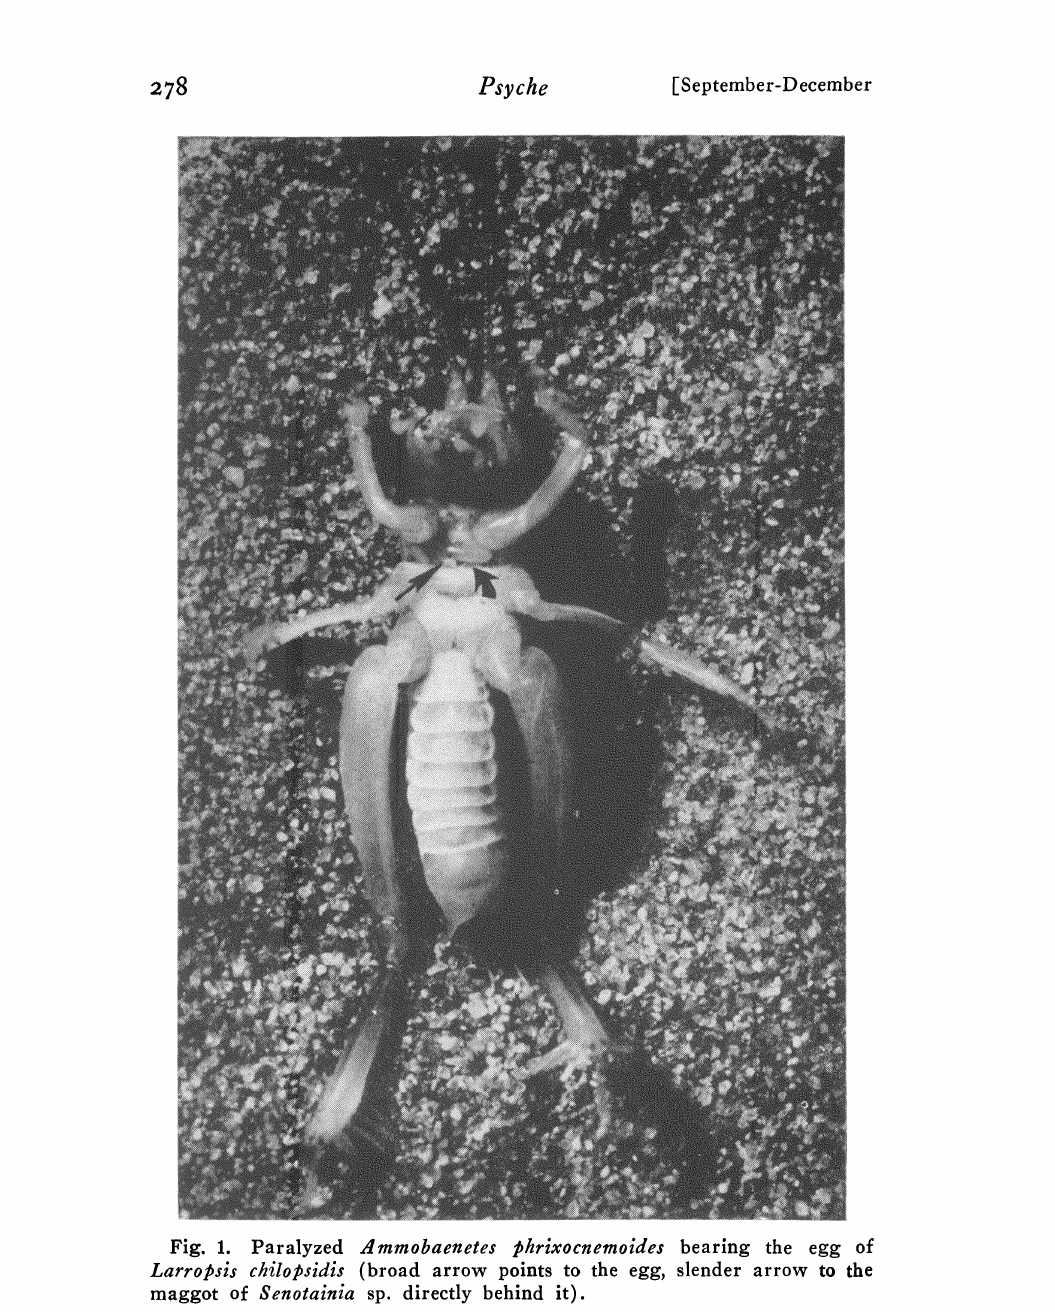
Fig. 1. Paralyzed ./lmmobaenetes phrixocnemoides bearing the egg of Larropsis chilopsidis (broad arrow points to the egg, slender arrow to the maggot of 8enotainia sp. directly behind